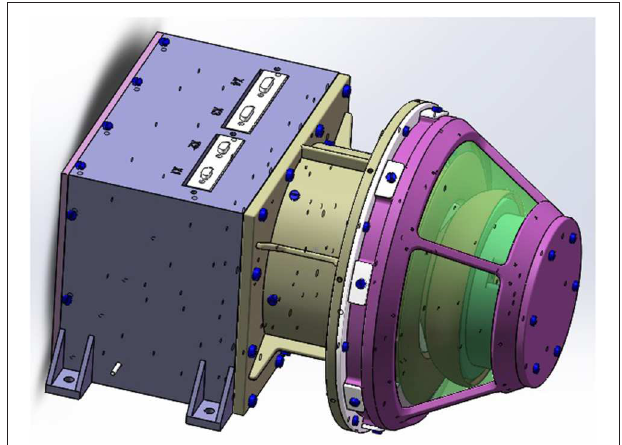
FIGURE 7 | The configuration of the thermal plasma (ions) detector, including the sensor and the electronic box.